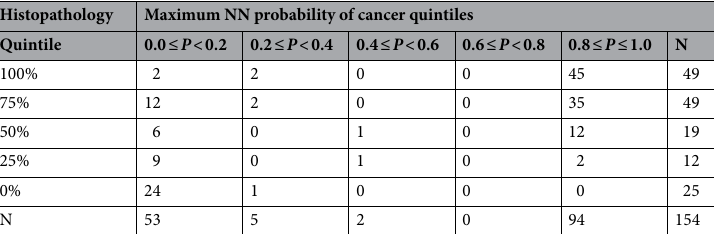
Table 7. Autonomous network assignment of cancer likelihood. Using the maximum prediction of cancer likelihood generated by NNs trained on FPHW, FP, or HW inputs with autonomous k-means classification as the gold standard, the original histopathology quintiles are cross-matched to five (5) equally spaced cancer probability bins. 147 of 154 spectra (95.4%) were assigned to end member quintiles: 0.0 ≤ P < 0.2 (N = 53, tumor unlikely) and 0.8 ≤ P ≤ 1.0 (N = 94, tumor highly likely). No targets received a probability score in the 0.6 ≤ P < 0.8 range. The average spectra for each of the other four probability quintiles appear in Fig. 8. 24